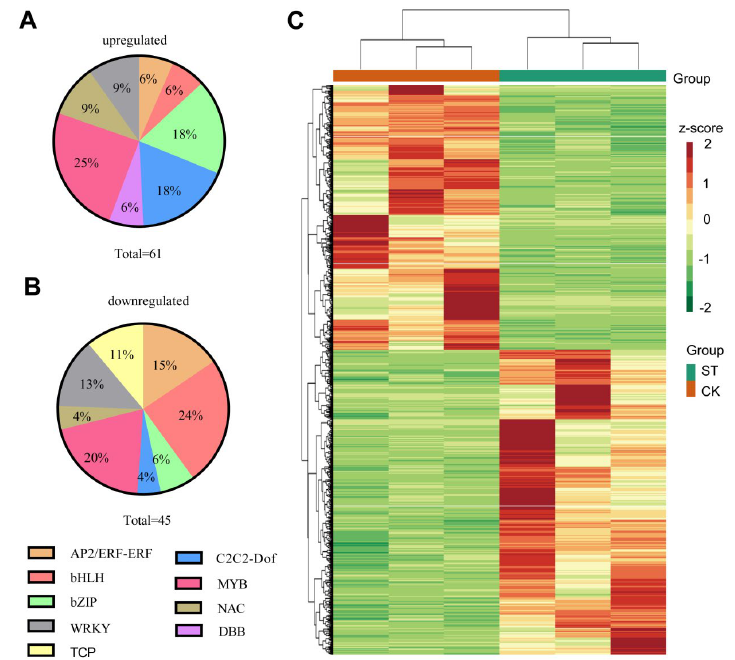
Figure 4. Distribution of transcription factors gene family with differential expression induced by low light treatments. ( A ) Upregulated. ( B ) Downregulated. ( C ) Heatmap representing the differentially expressed genes related to the anthocyanin biosynthesis pathway induced by low light treatment (ST) and control (CK). Horticulturae 2022 , 8 , x FOR PEER REVIEW To confirm the expression levels of some key genes in response to low light treat- ment, we conducted q-RT-PCR experiments. The expression levels of four DEGs related to anthocyanin biosynthetic pathway were determined, including BrLDOX (Bra019350), BrDFR (Bra027457), Br5MAT (Bra036208) and BrUGT75C1 (Bra038445), together with two transcription factors, i.e., BrTCP15b (Bra004407) and BrTCP15 (Bra007875). Results show that the expression levels of genes related to anthocyanin biosynthetic pathway including BrLDOX , BrDFR , Br5MAT and BrUGT75C1 were inhibited by 2–4 times. In contrast, the expression level of two TCP genes, i.e., BrTCP15 and BrTCP15b were substantially inhib- ited. In particular, the expression levels of BrTCP15 were inhibited by up to two times (Figure 5A–F). These results suggest that low light inhibits the expression of genes related to anthocyanin biosynthesis as well as the expression of some TCP genes.